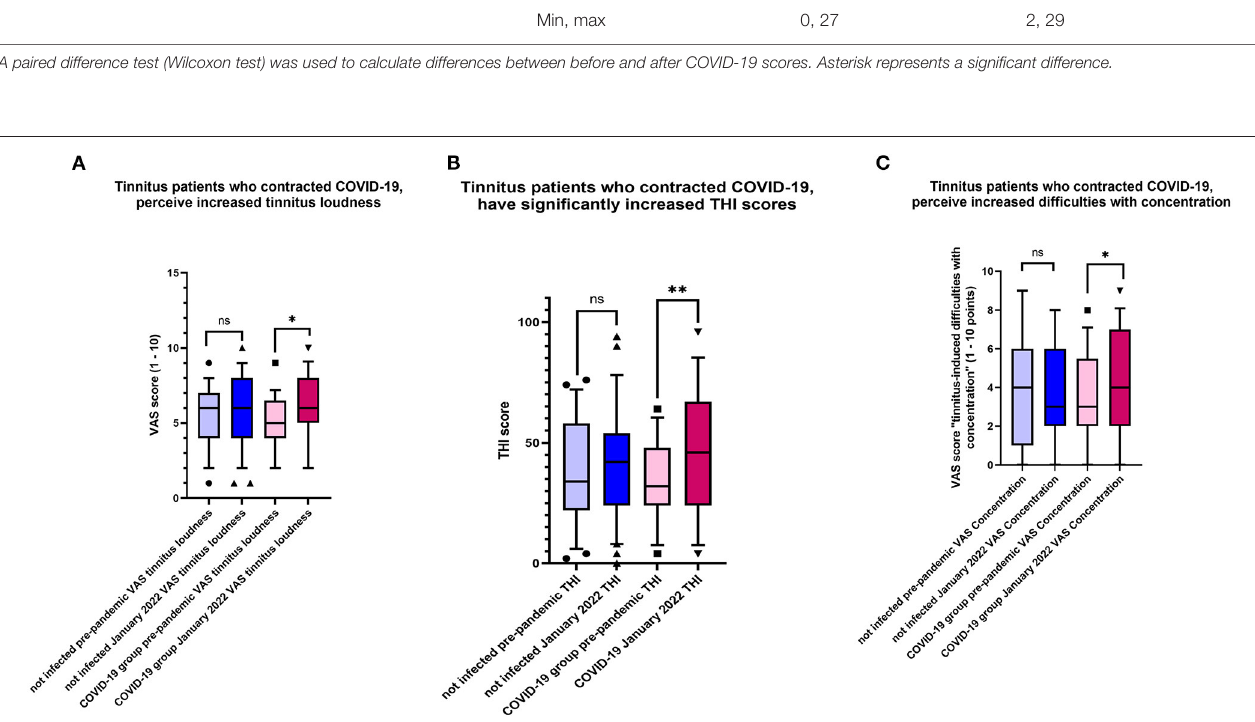
Frontiers in Neurology |